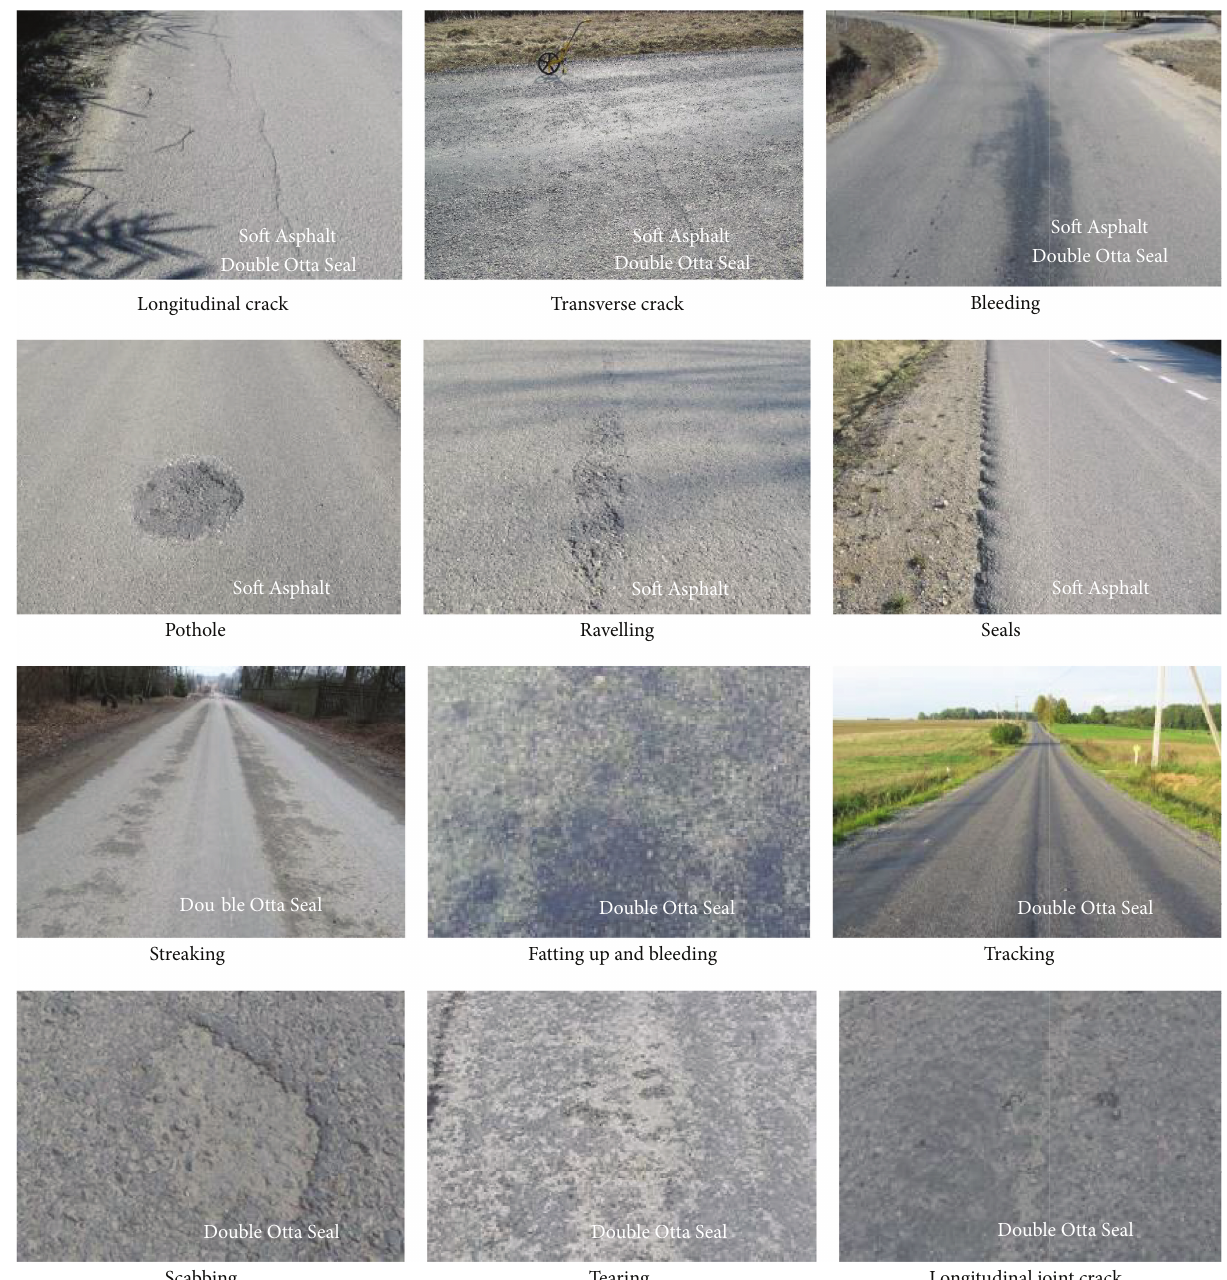
Figure 3: Defects that are the criteria for assessing the pavement